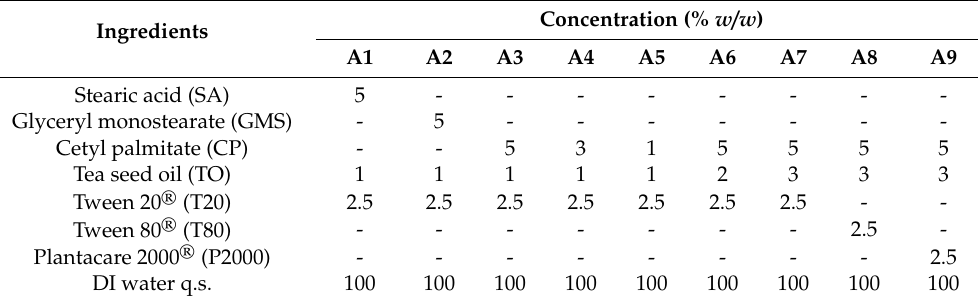
Table 1. Composition of Nanostructured Lipid Carrier (NLC)